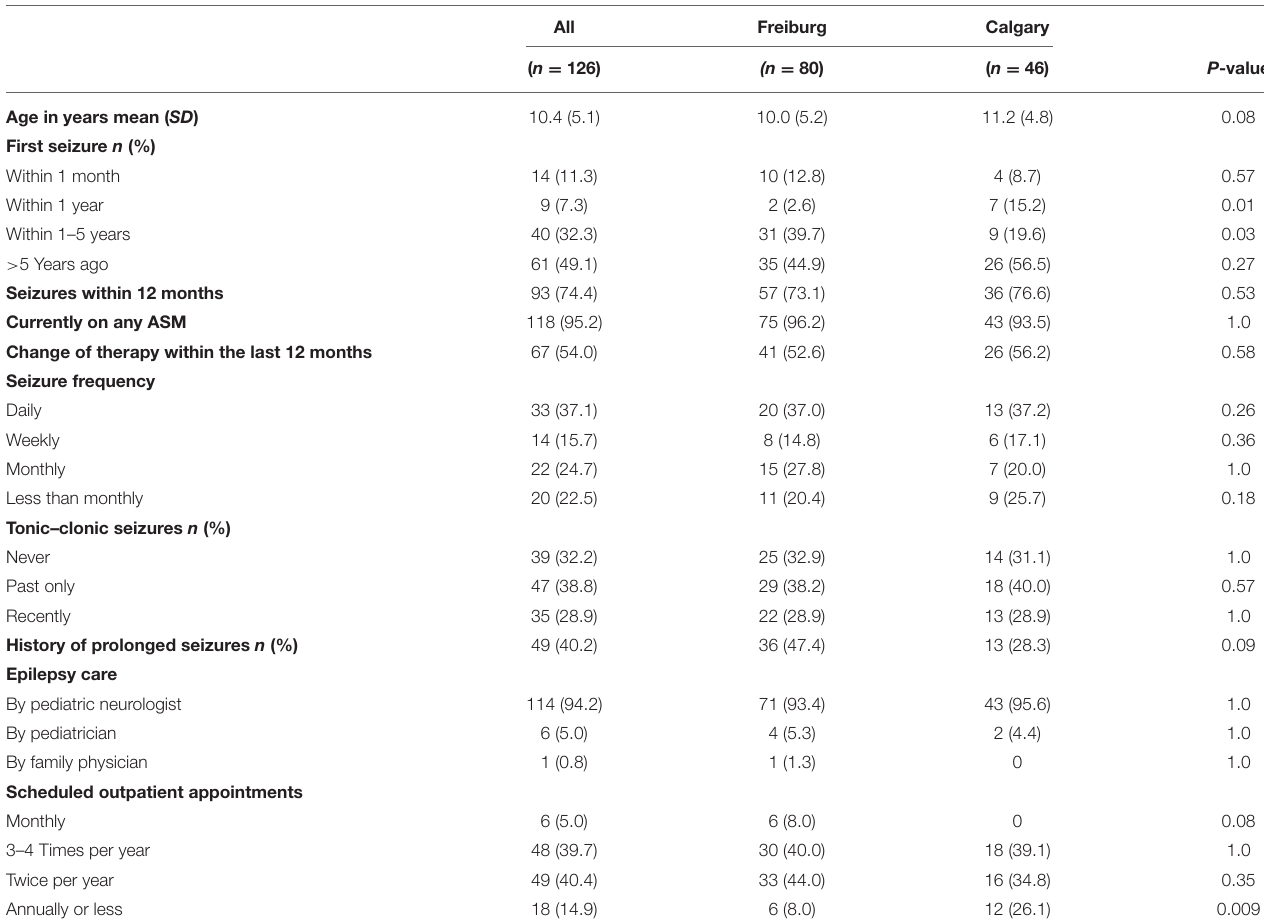
TABLE 1 | Patient characteristics.